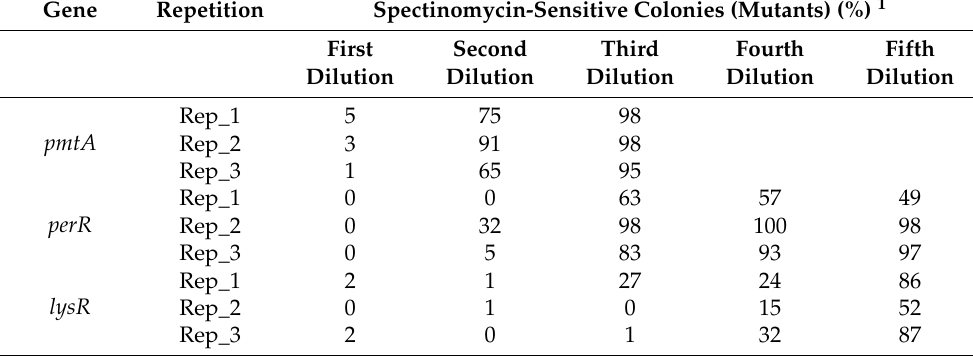
Table 2. The proportion of spectinomycin-sensitive colonies